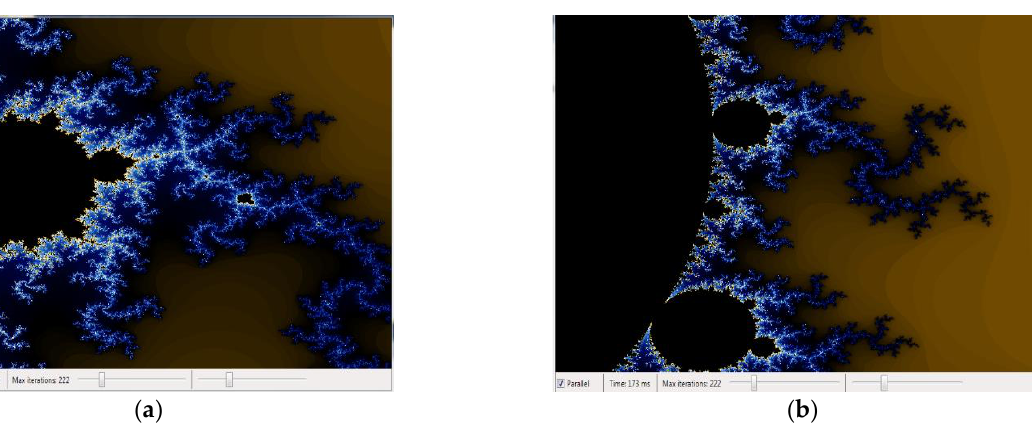
Figure 8. Evolution of time generation for sequential algorithm and parallel algorithm. ( a ) Image generated with sequential algorithm. ( b ) Image generated with a parallel algorithm.